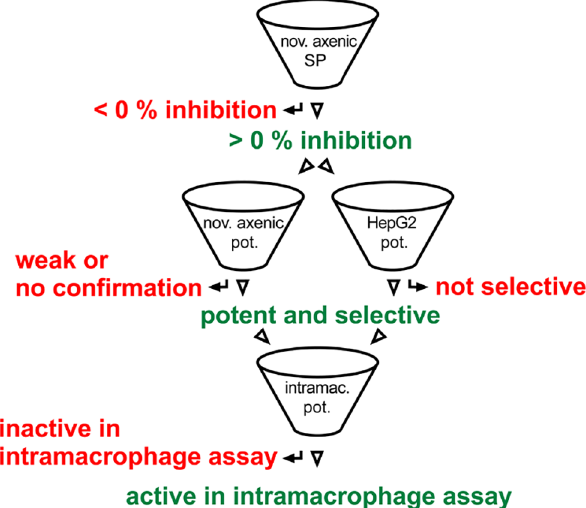
Fig 4. Screening cascade. Novel axenic assay is primary, single concentration (SP) entry to the cascade, followed by confirmation, assessment of potency and selectivity using the novel axenic assay and a mammalian counterscreen assay (HepG2) in potency mode (pot.). Potent and selective hits are then profiled in the intramacrophage